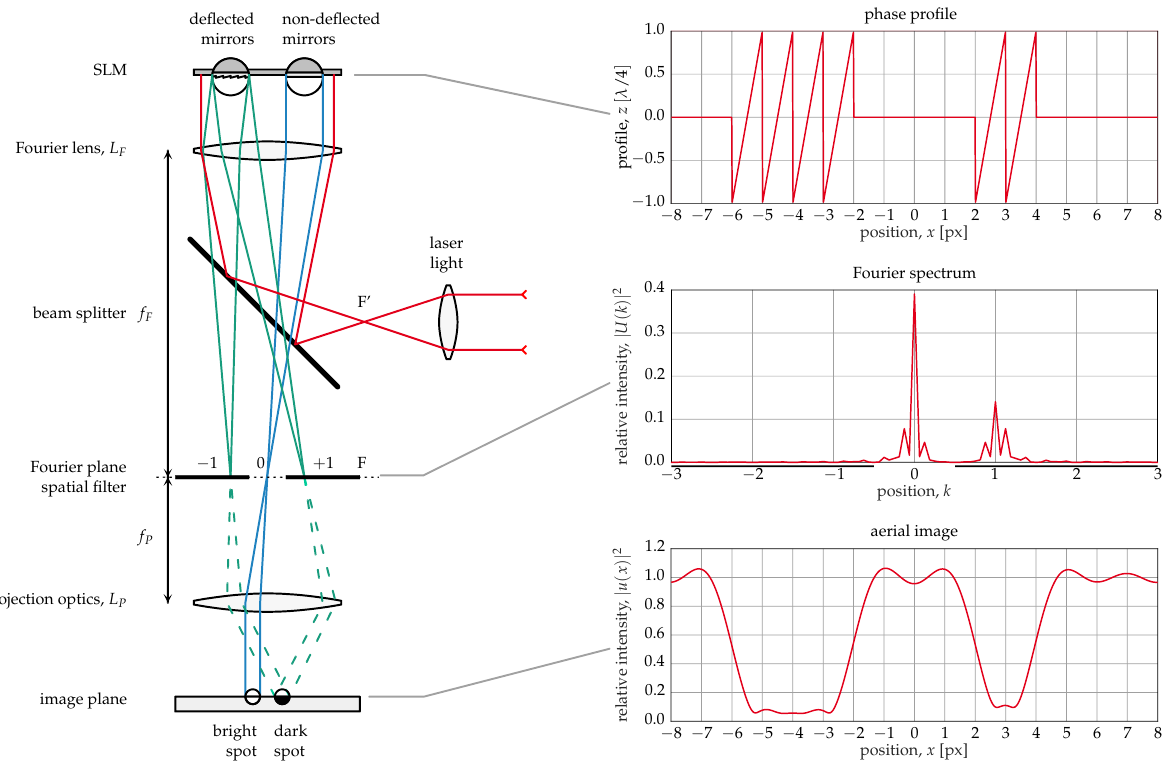
Figure 2. Fourier optical imaging